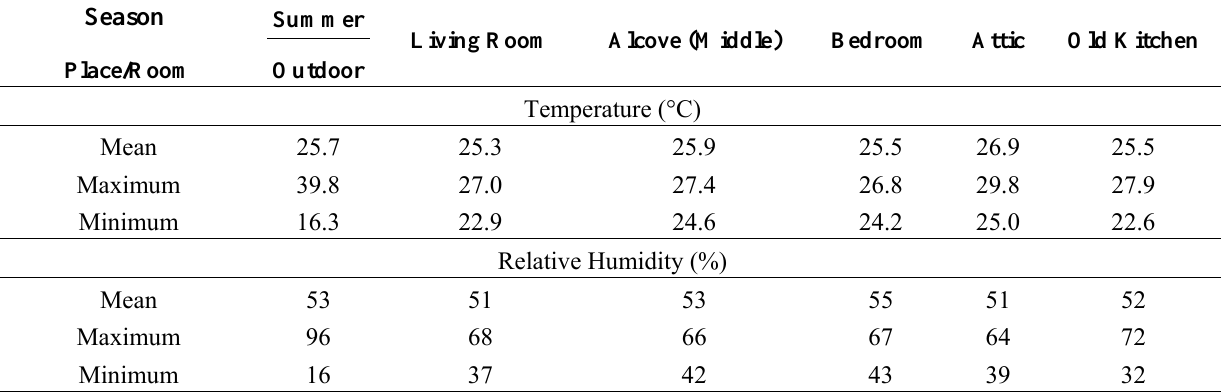
Figure 12. Case study 2 performance during summer season. ( a ) Indoor and outdoor air temperature profile; ( b ) Indoor and outdoor relative humidity profile. Table 3. Comparison of outdoors and indoors air temperature and relative humidity values in Case Study 2 during summer